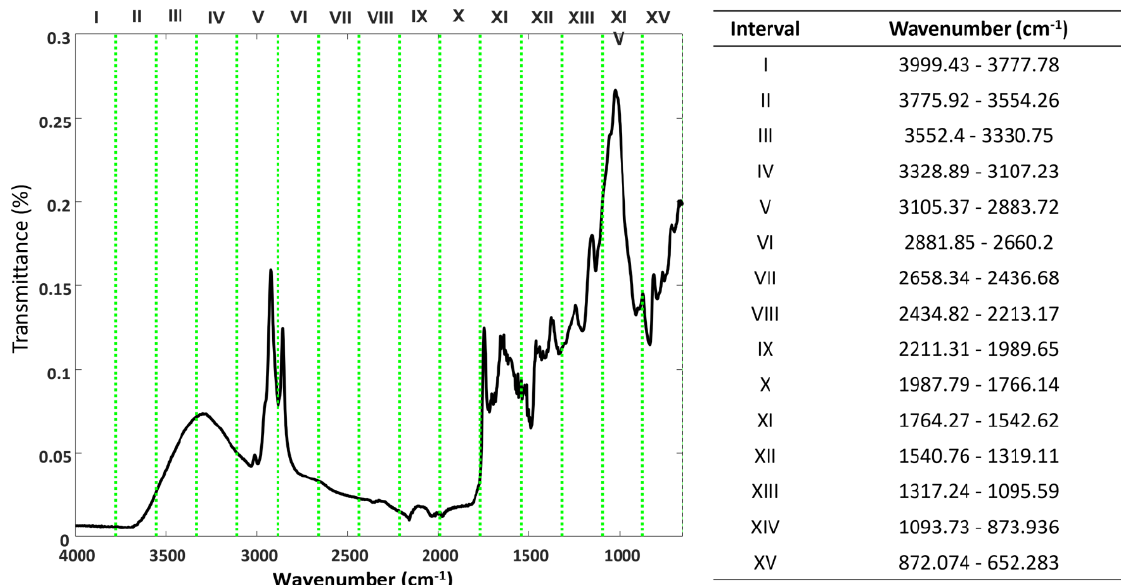
Figure 3. Infrared spectrum obtained from coffee samples roasted in different roasting profiles (baked, light, medium, and dark) using two roasters (Probatino and Golden Plus). This spectrum was divided into 15 intervals (I to XV) for application of the Interval Principal Component Analysis (iPCA) technique.